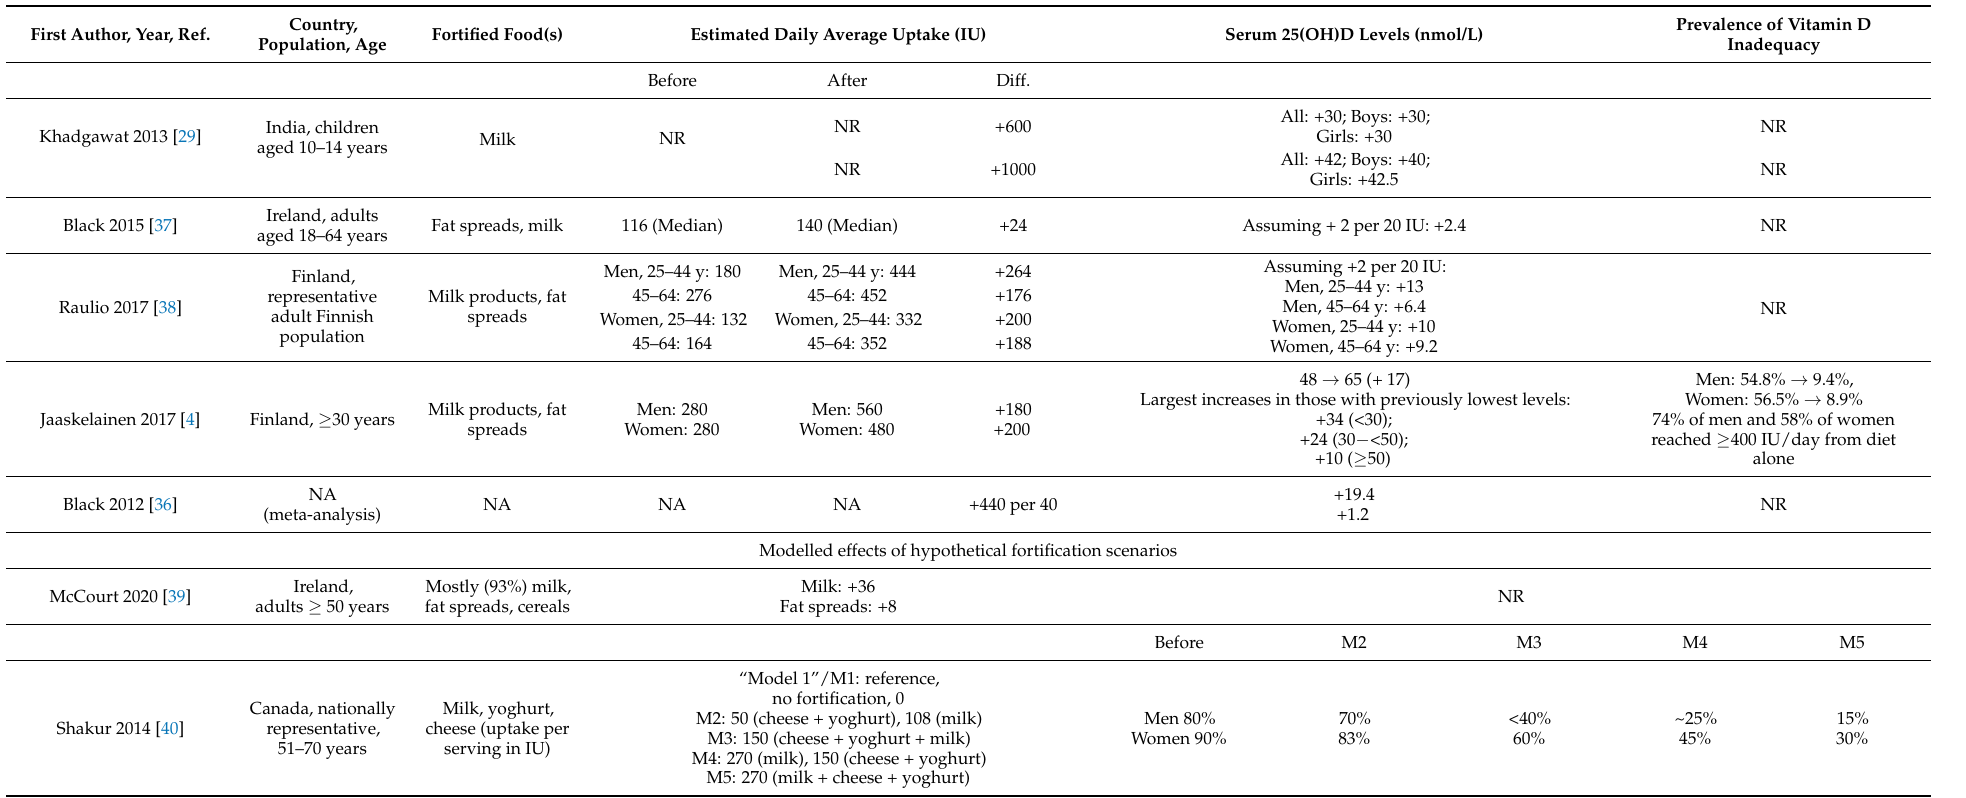
Table 4. Uptake of vitamin D, including uptake from fortified